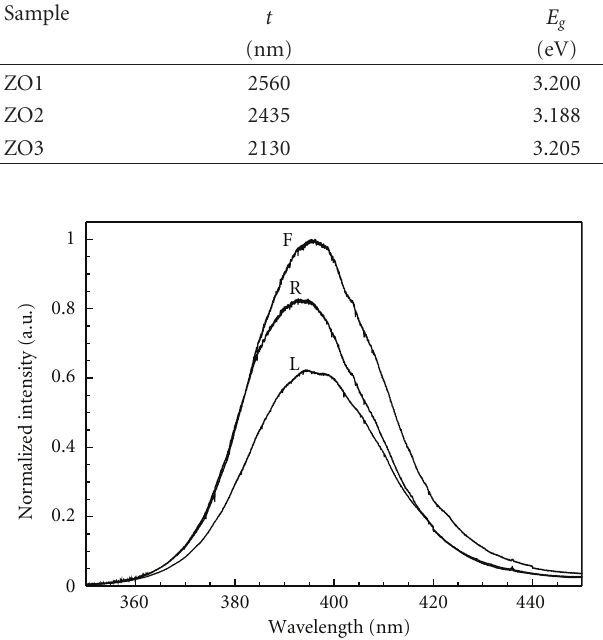
Figure 2: PL spectra of ZnO thin films at room temperature (The labels R, L, and F were used for deposited film on the rotated substrate, for deposited film on the linear moved substrate and for deposited film on the fixed substrate,